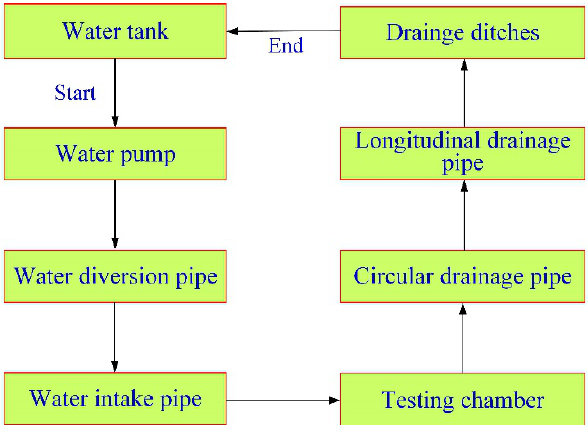
Figure 2. Schematic diagram of solution circulation.